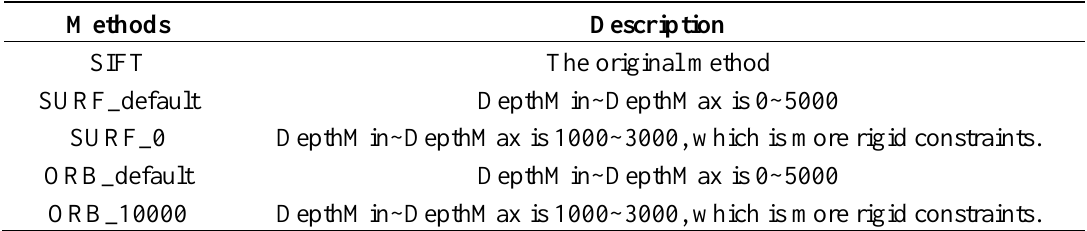
Table 2. Method Description.